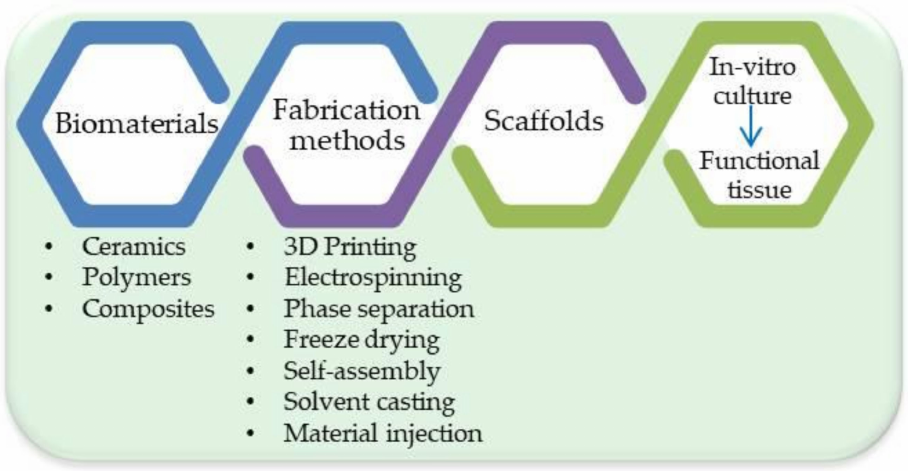
Figure 1. Tissue Engineering